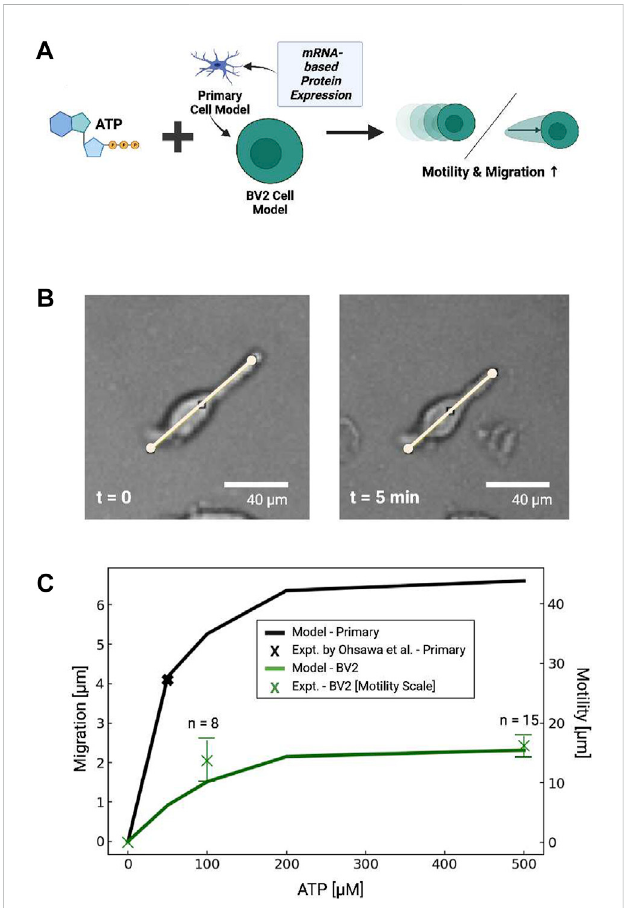
FIGURE 8 (A) Schematic of predicted migration or displacement in primary microglial cells or cells with P2 expression estimated from BV2 cell mRNA (He et al., 2018). (B) Bright fi eld image demonstrating ATP- dependent displacement ofmicroglial cellmembrane(100 µMATP at 5 min) (C) Predicted (lines) migration or displacement distance following 5 min ATP treatment (0 – 500 µM) in primary microglia (blue) and BV2 cells (green). Experimental data in primary cells from Ohsawa etal.(2004)andmeasuredinBV2cellsareshownbyblackandgreenX ’ s, respectively, where the bars represent standard